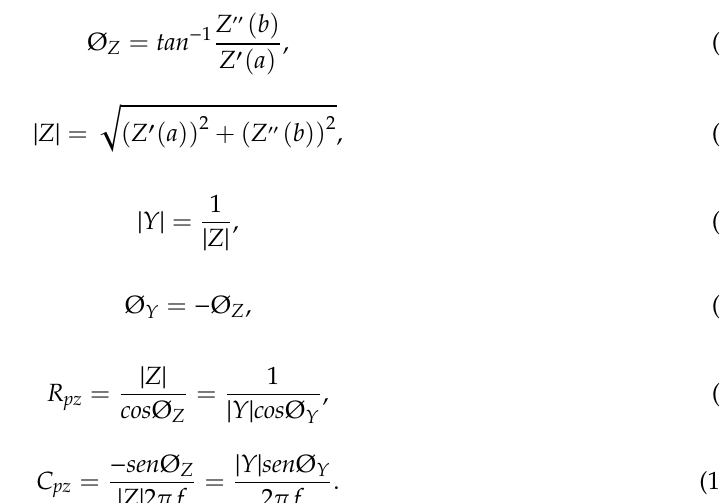
Figure 8. Impedance measurement of the PDUTs: ( a ) Lead-containing PZT; ( b ) lead (Pb)-free.